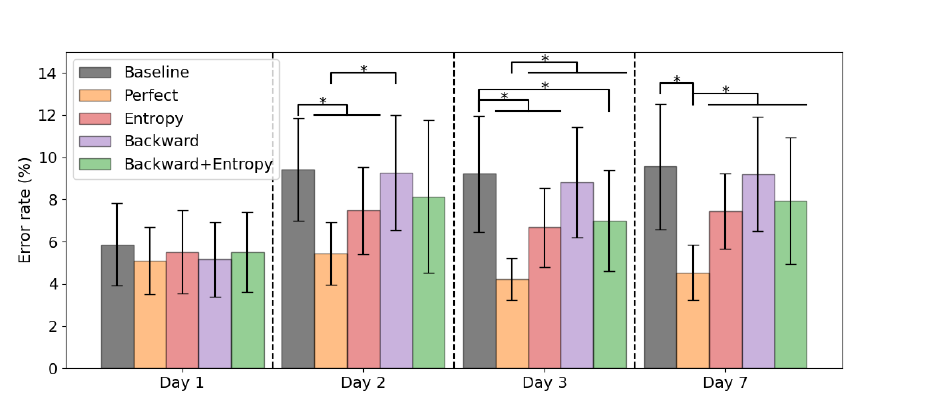
Figure 5. Average forward prediction error rates with standard deviation of baseline and adaptation strategies per day. Asterisk indicates significant difference.